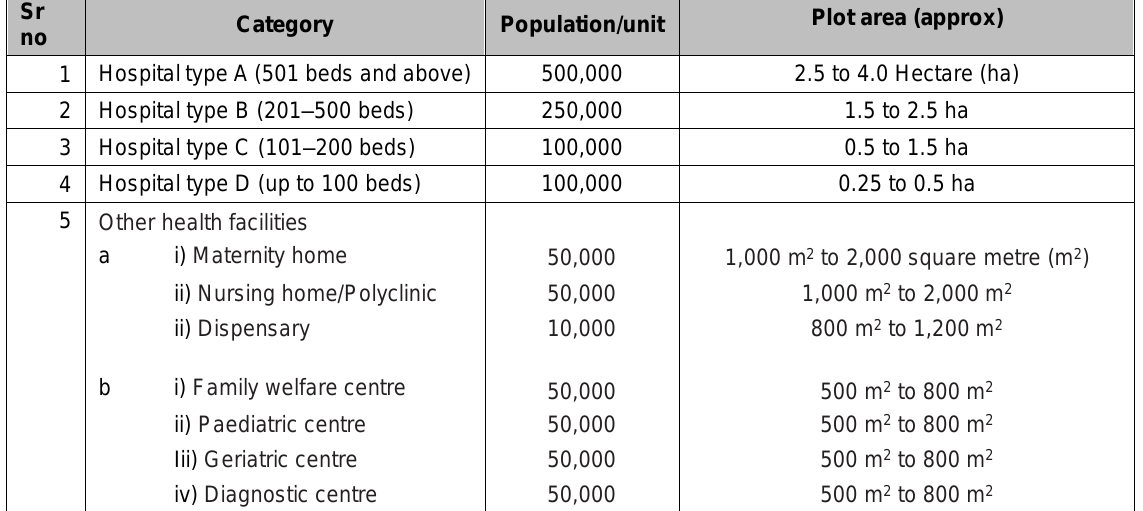
Table 1: Planning norms and standards for health services in